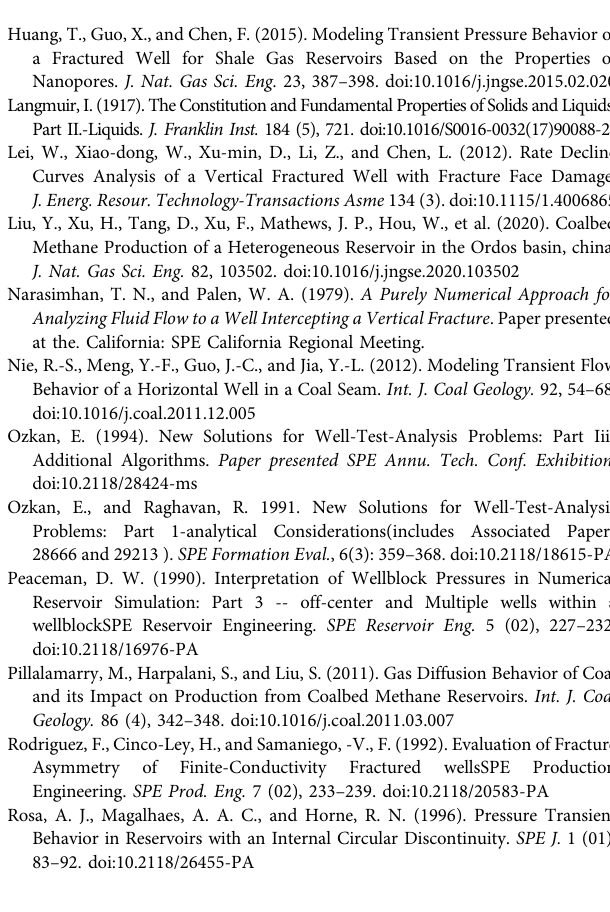
Figure description, supervision, model validation FC: